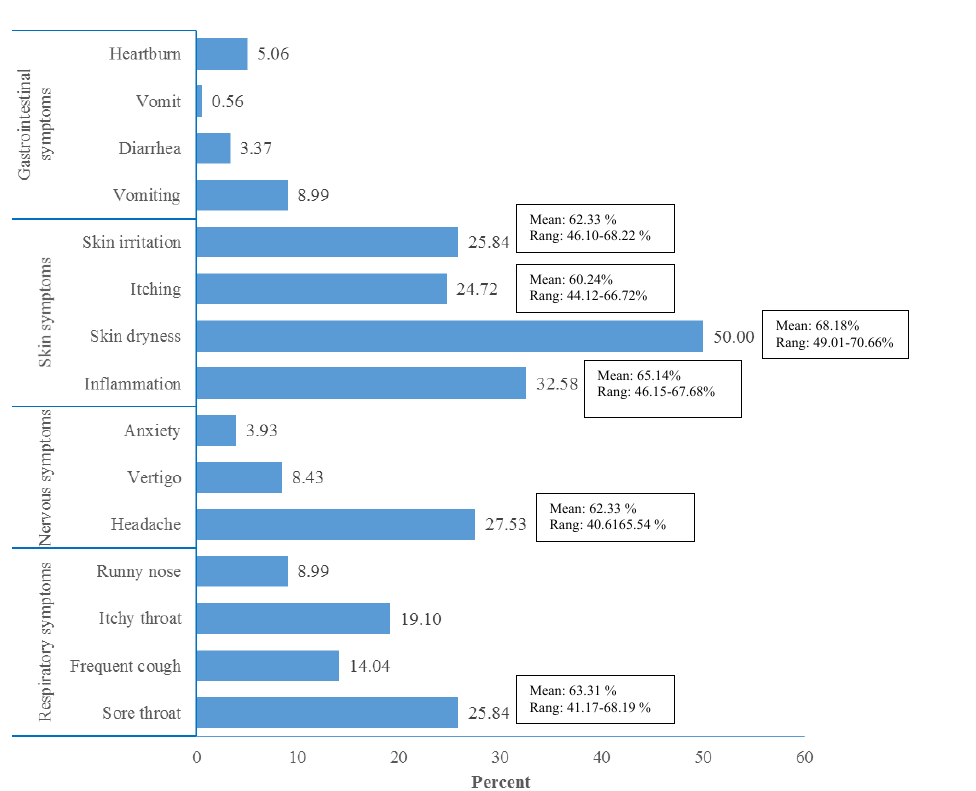
Poormohammadi et al. Adverse Health Effects and Complications of Hand Sanitizers. J Adv Environ Health Res. 2022; 10(3):217-224